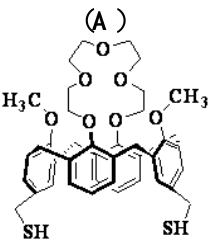
Figure 1. Molecular structure of ( A ) calix[4]crown; ( B ) arginine; ( C ) Schematic diagram of the sensor chip